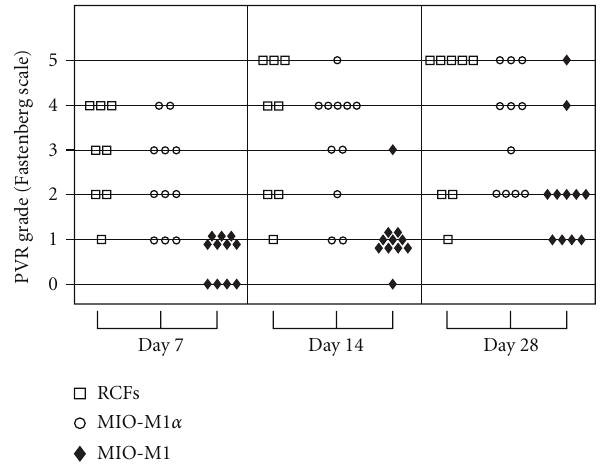
Figure 4: Overexpression of PDGFR α in MIO-M1 MPCs induces a phenotypic switch to fibroblast-like cells that e ff ectively induce PVR postintravitreal injection in rabbit. Classification is as follows: stage 0—no PVR; stage 1—presence of fibrous bands; stage 2— fibrous bands with traction; stage 3—retinal detachment involving less than 2 quadrants; stage 4—retinal detachment involving more than 2 quadrants; stage 5—total retinal detachment. For statistical purposes, stage 3 or higher is considered severe PVR. Mann-Whitney statistical analysis for nonparametric data showed a statistically significant di ff erence ( P < 0 . 05) at all three time points between RCFs versus MIO-M1 MPCs, and MIO-M1 MPCs versus MIO-M1 α MPCs. No statistically significant di ff erence was observed between RFCs versus MIO-M1 α